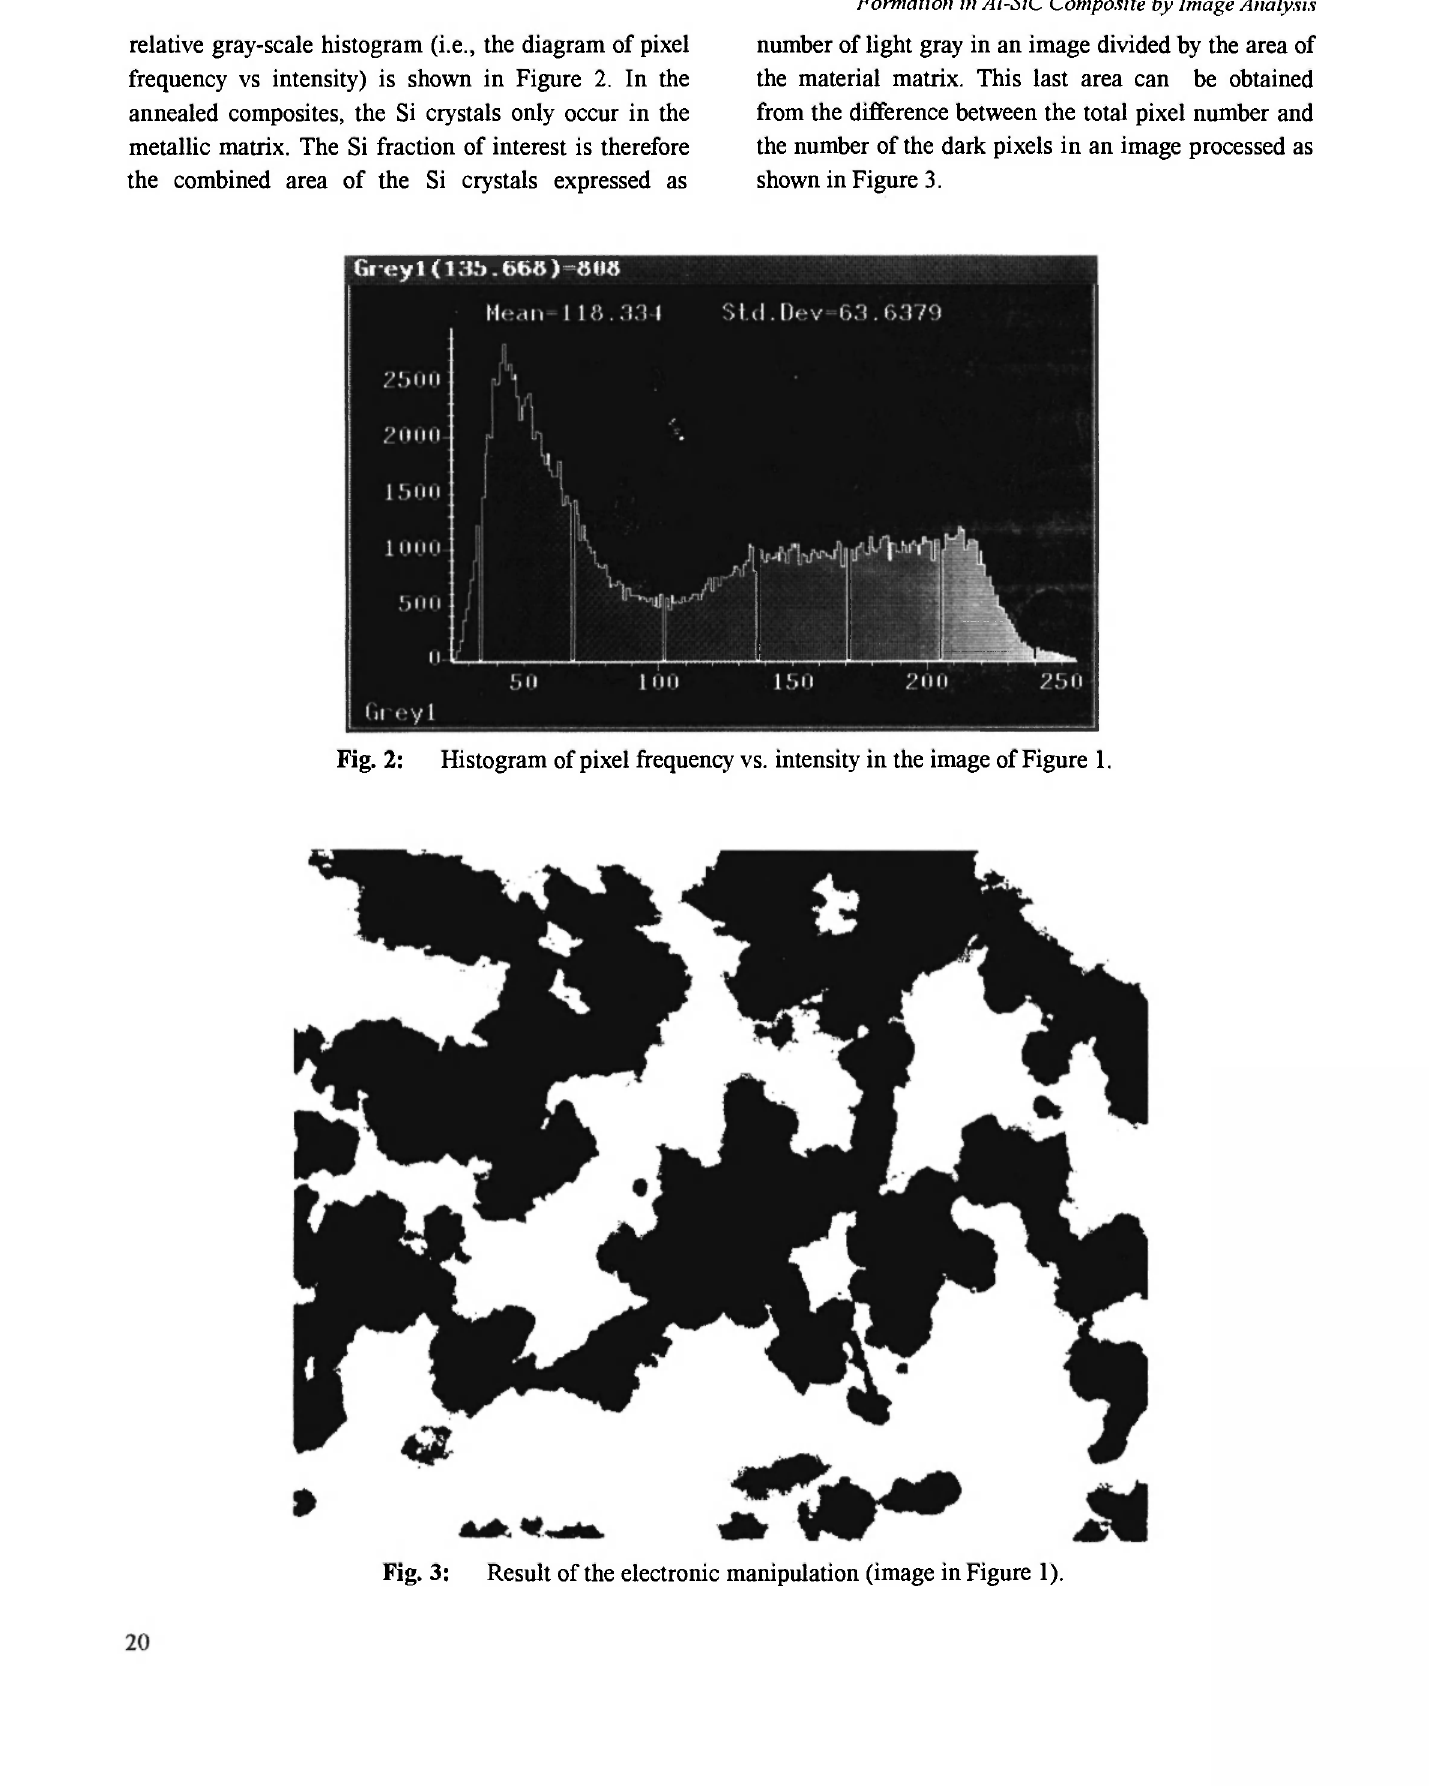
Fig. 3: Result of the electronic manipulation (image in Figure